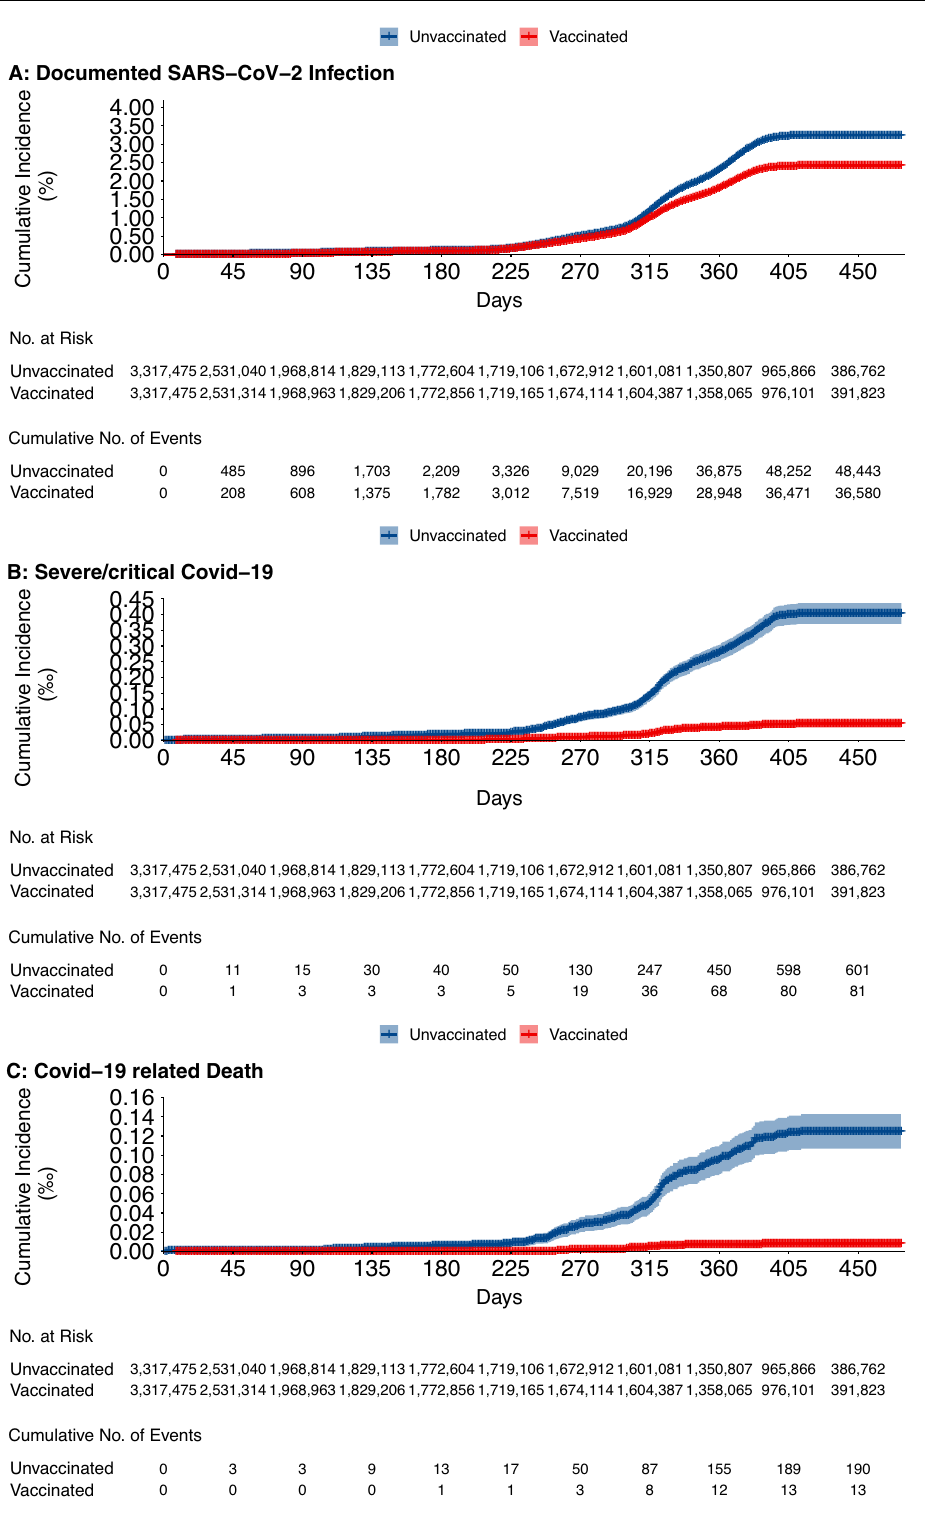
Fig. 3 | Cumulative incidence of three outcomes in cohort 1. A SARS-CoV-2 infection, B Severe/critical Covid-19, and C Covid-19 related diagnosis, and treatment for infection, and cases had a milder clinical severity. In Table 3, which shows results when three subsets were selected from cohort 1, we found that vaccine protection was better provided by three-dose regimens than two- or one-dose.